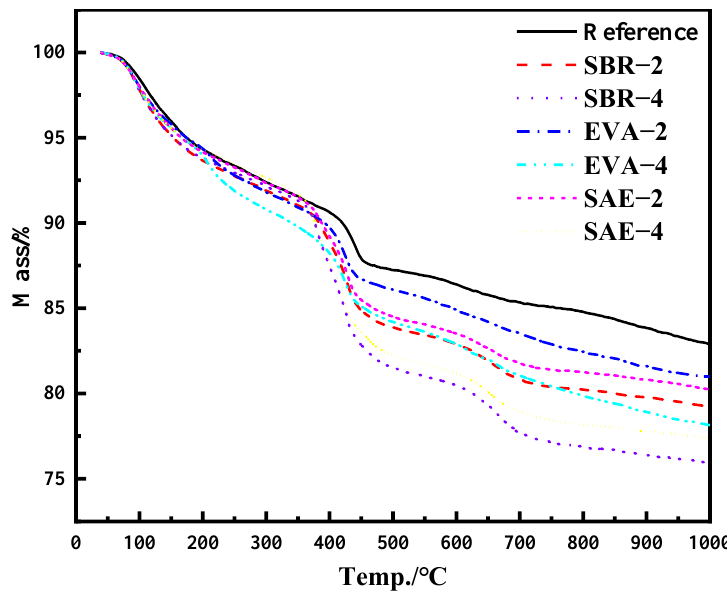
Figure 6. TG diagram of paste samples with different polymer latex types and contents at 28 days.